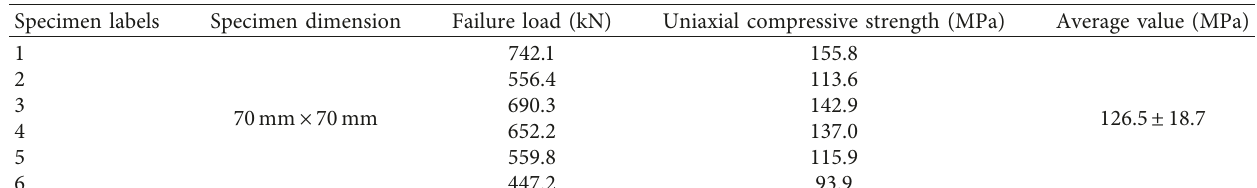
Figure 2: Failure mode of the granite stone cubic block. Table 1: Compressive test results.